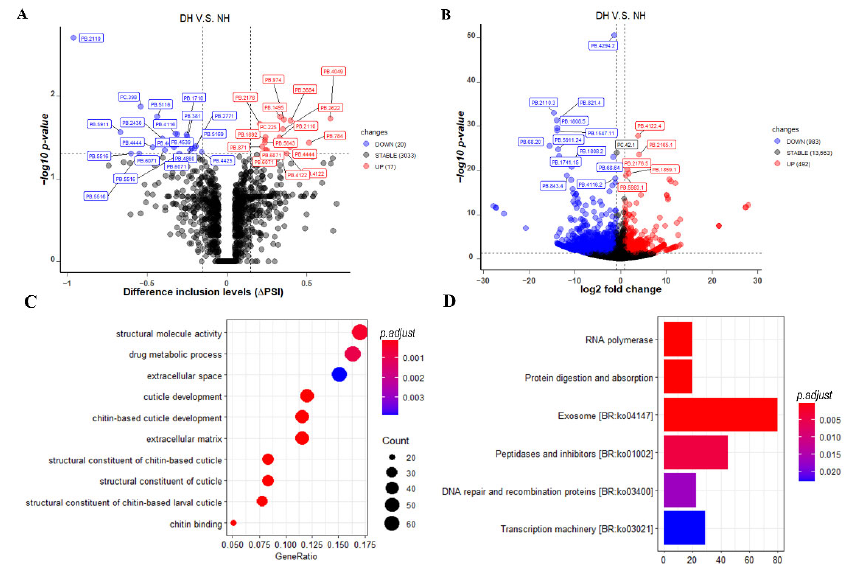
Figure 4. Differential expression analysis and enrichment analysis between DH and NH. ( A ) The volcano plot indicates p -values with minus log10-transformed for AS events (Y-axis) against their corresponding difference in inclusion levels ( ∆ PSI) of each AS event (X-axis). The horizontal gray dotted line represents the significant threshold (0.05). The red, blue, and gray points represent up-regulated, down-regulated, and non-regulated AS events in DH groups, respectively. ( B ) The volcano plot indicates with minus log10-transformed for genes (Y-axis) against their corresponding log2(|fold change|) of echo gene (X-axis). ( C ) The top ten significant gene ontology (GO) terms obtained from GO enrichment analysis using genes with DAS events or DETs in SPA, NH, and DH, respectively. The Y-axis represents different GO term categories. The X-axis represents the proportion of significant expressed genes in the list of corresponding GO terms (GeneRatio). Different sizes and colors of circle represent the number of significantly expressed genes and corresponding adjusted p -value of GO terms. ( D ) The top ten significant pathways obtained from KEGG enrichment analysis using genes with DAS events or DEGs in SPA, NH, and DH, respectively. The Y axis represents different pathways categories. The X-axis represents the number of significantly expressed genes in the corresponding pathway. Different colors represent the different adjusted p -value of pathway.